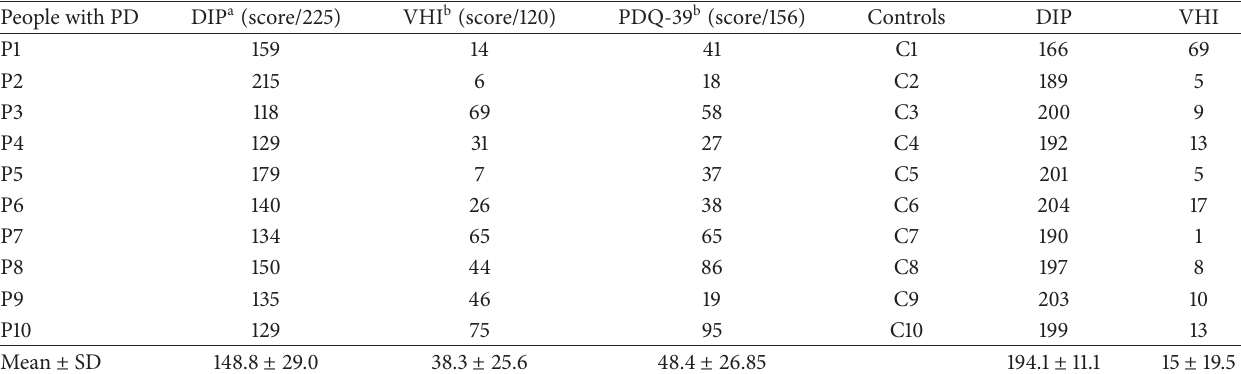
Table 2: Total and mean scores from self-assessments.